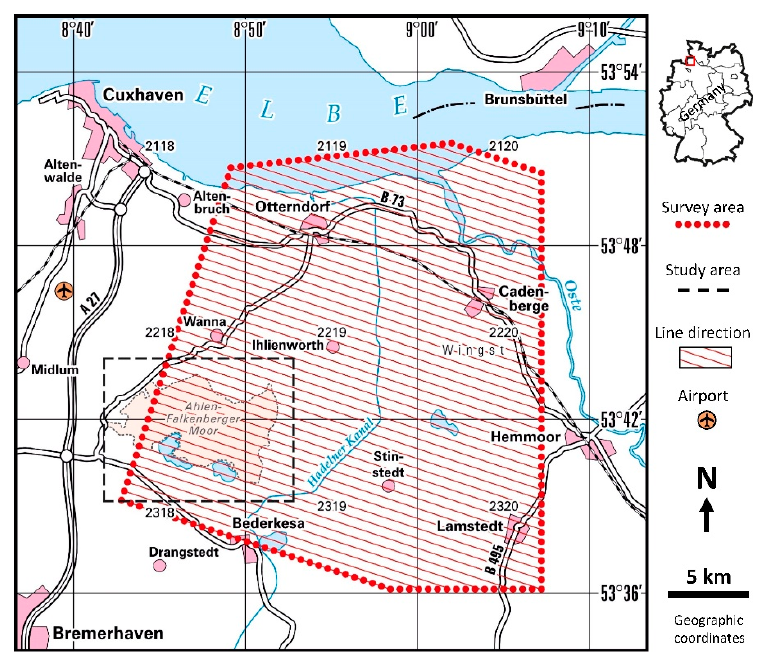
Figure 1. Airborne survey area (red dots) and location of the study area (dashed black rectangle) of the Ahlen-Falkenberger Moor in northwest Germany.